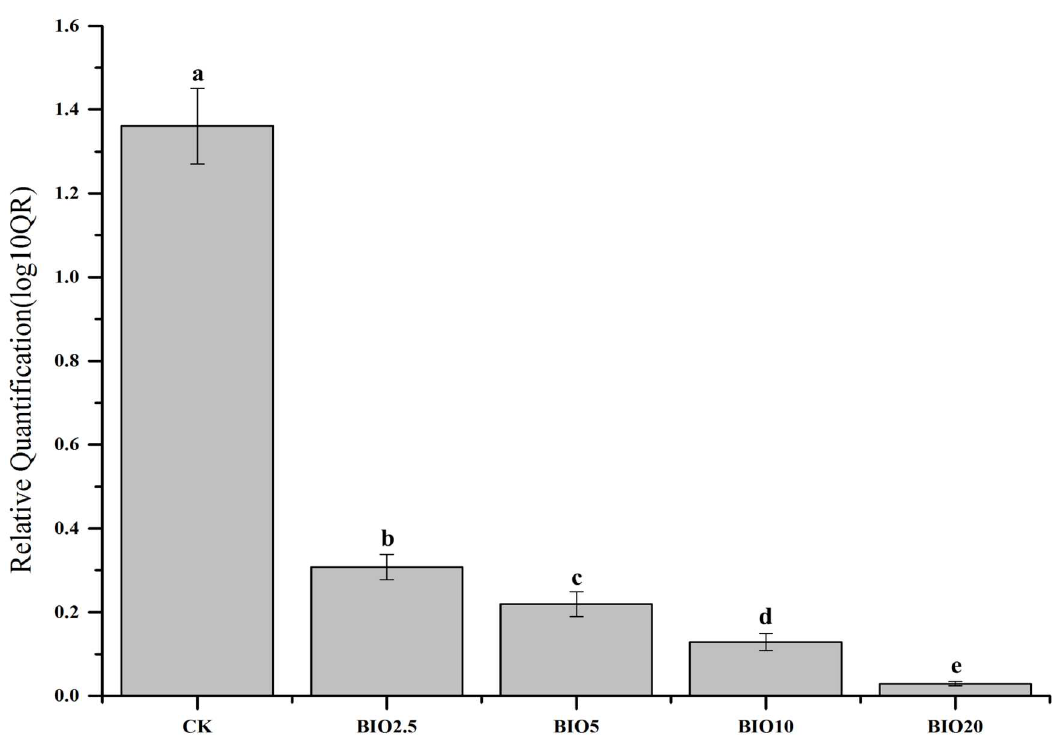
Fig 3. Real-time PCR relative quantification of F . oxysporum f. sp. cucumerinum in soils. Columns with different letters are significantly different accordingto Duncan’stest ( p <